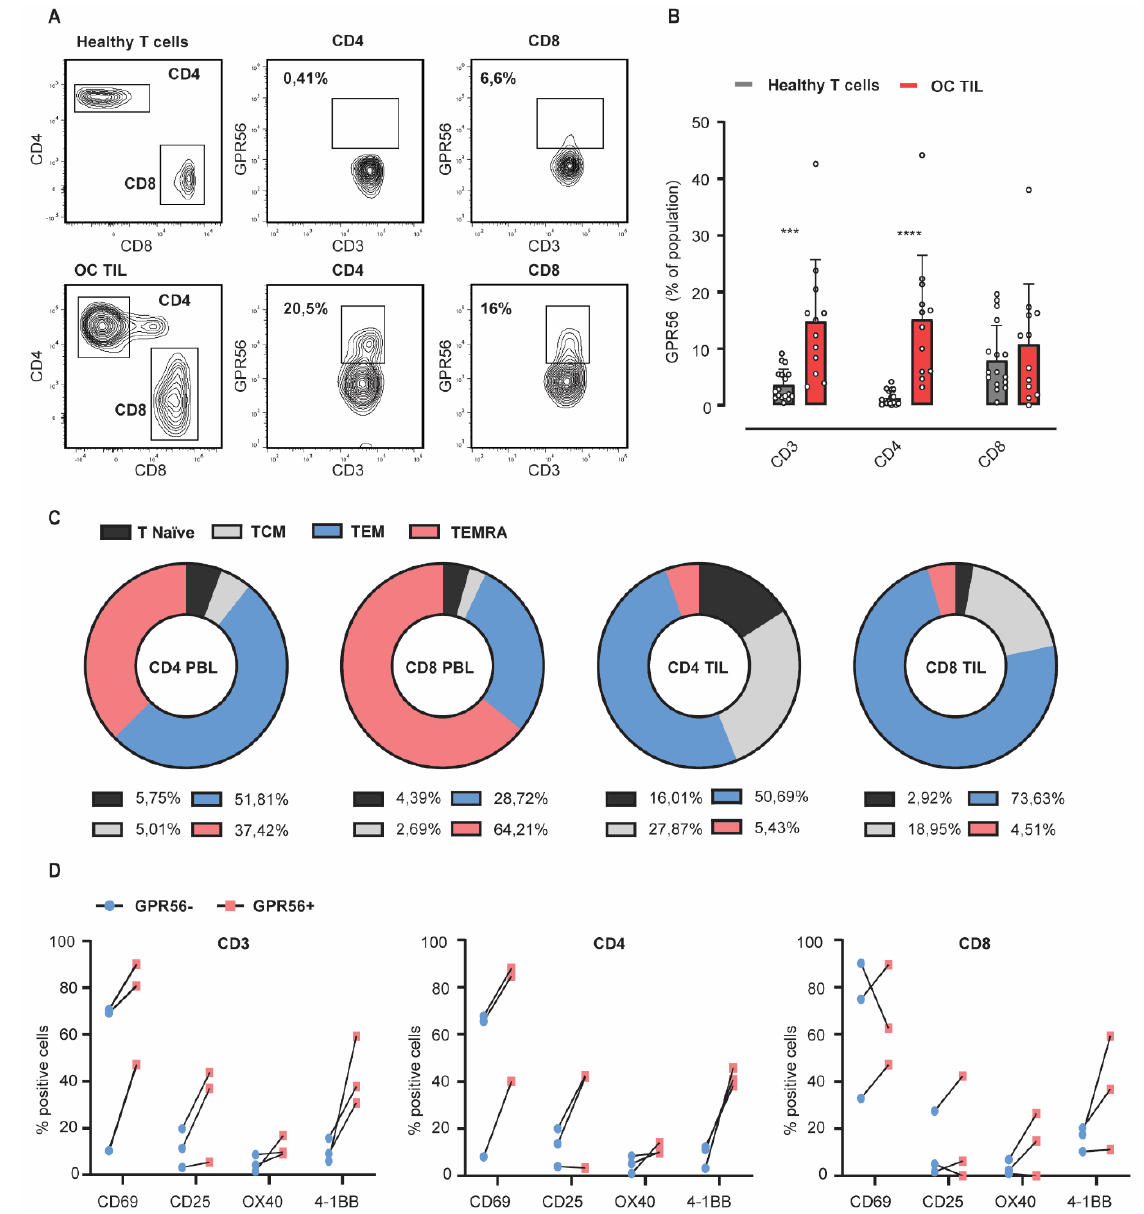
Figure 3. GPR56 expression is elevated on ovarian cancer TILs compared to healthy peripheral blood lymphocytes and associates with an effector memory phenotype. ( A , B ) GPR56 expression analyzed on CD3, CD4 and CD8 fractions of healthy T cells and ovarian cancer TILs ( n > 10) by flow cytometry. A 2way ANOVA was performed to determine significance. ( C ) Different T cell developmental subsets (naïve, central memory, effector memory and effector memory RA (based on CD45RO and CCR7 expression) within the GPR56-positive CD4 and CD8 T cell fractions of peripheral blood lymphocytes and ovarian cancer TILs ( n > 5). ( D ) Expression levels of effector (CD69 and CD25) and co-stimulatory (OX40 and 4-1BB) molecules within the GPR56-positive CD3, CD4 and CD8 T cell fractions of ovarian cancer TILs from 3 different donors. Individual donor variations between the GPR56+ and GPR56- fractions are displayed. Across the figure, t -test values: *** = p < 0.001, **** = p < 0.0001, all error bars in the figure represent